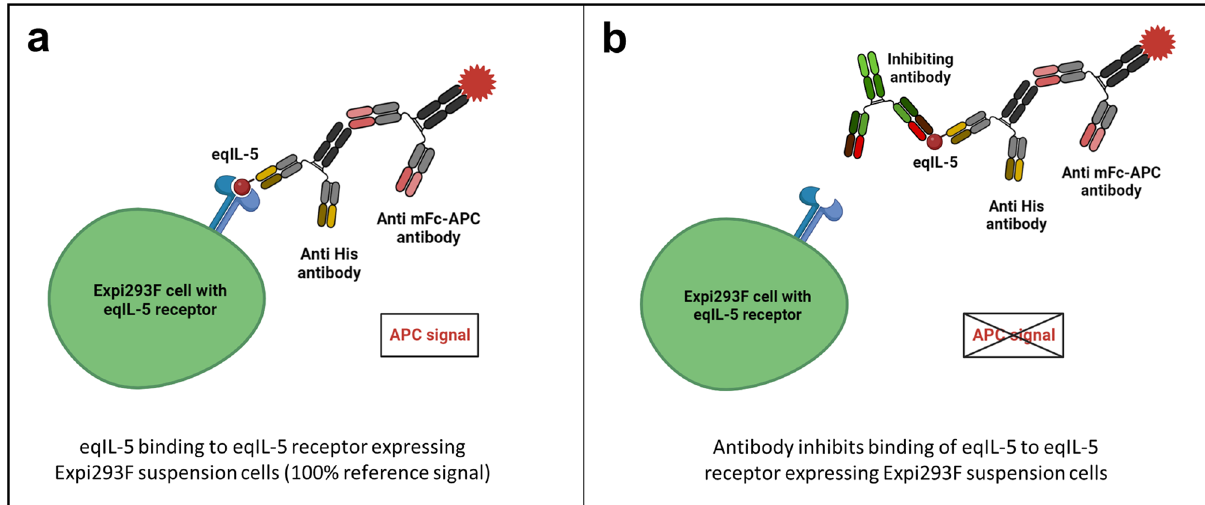
Figure 4. Setup of cellular in vitro inhibition assay. ( a ) EqIL-5 binding to eqIL-5 receptor expressing Expi293F suspension cells. The binding is detected via Penta-His antibody and a goat anti mouse Fc antibody coupled to APC. The APC signal represents the 100% binding reference signal. ( b ) Pre-incubation of antibody and antigen leads to inhibition of eqIL-5 binding to eqIL-5 receptor expressing Expi293 suspension cells. The APC signal is reduced compared to the 100% binding reference depending on the inhibition effect of the